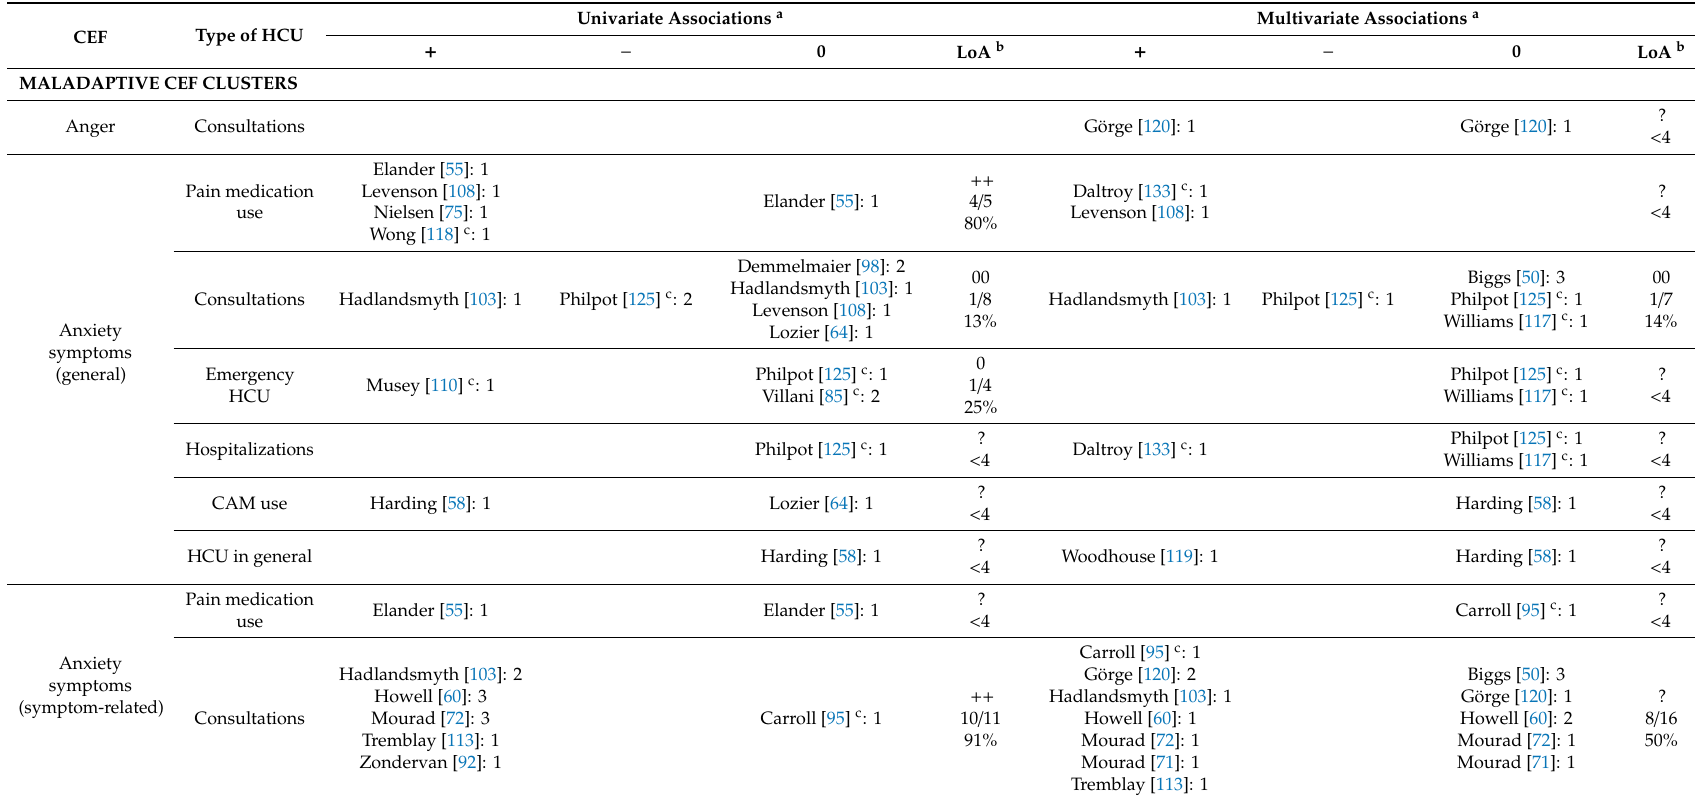
Table A4. Associations between amount of HCU and CEF in people experiencing